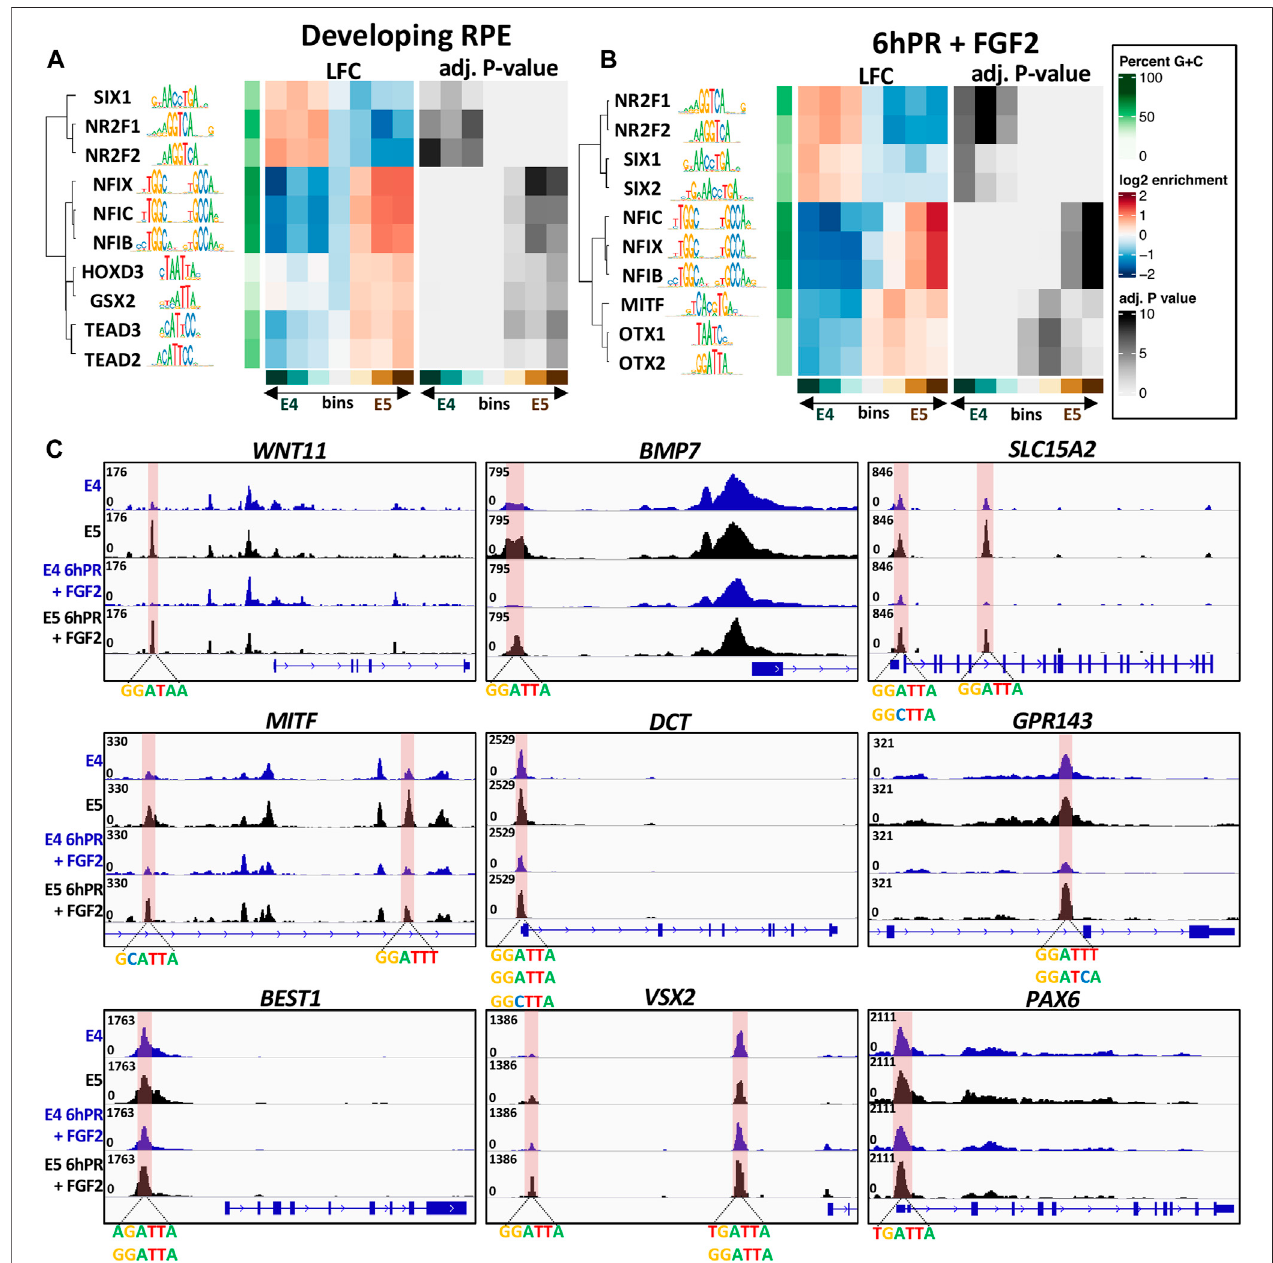
FIGURE 7 | Overrepresented motifs in open regions of the E4/E5 RPE. The monaLisa motif analysis software was used to bin differentially accessible summits by accessibility across the E4 and E5 conditions. Each bin was analyzed for the overrepresentation of transcription factor motifs found in the JASPAR 2022 database. Enriched motifs identi fi ed at − log(p-Adj.) > 3 in any bin were recorded and select factors associated with the developing RPE (A) or 6hPR + FGF2 (B) samples were plotted. (C) GenomebrowserdisplaysATAC-signalproximaltoDARscontainingtheOTX2bindingmotif.Theregionofinterestishighlightedinpinkandassociated motifs are summarized below the